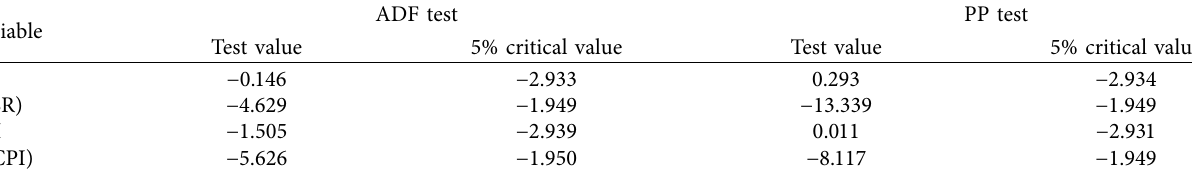
Table 3: Unit root test results of